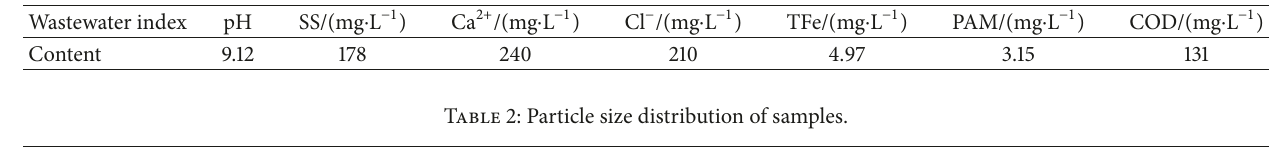
Table 1: Wastewater quality monitoring data.